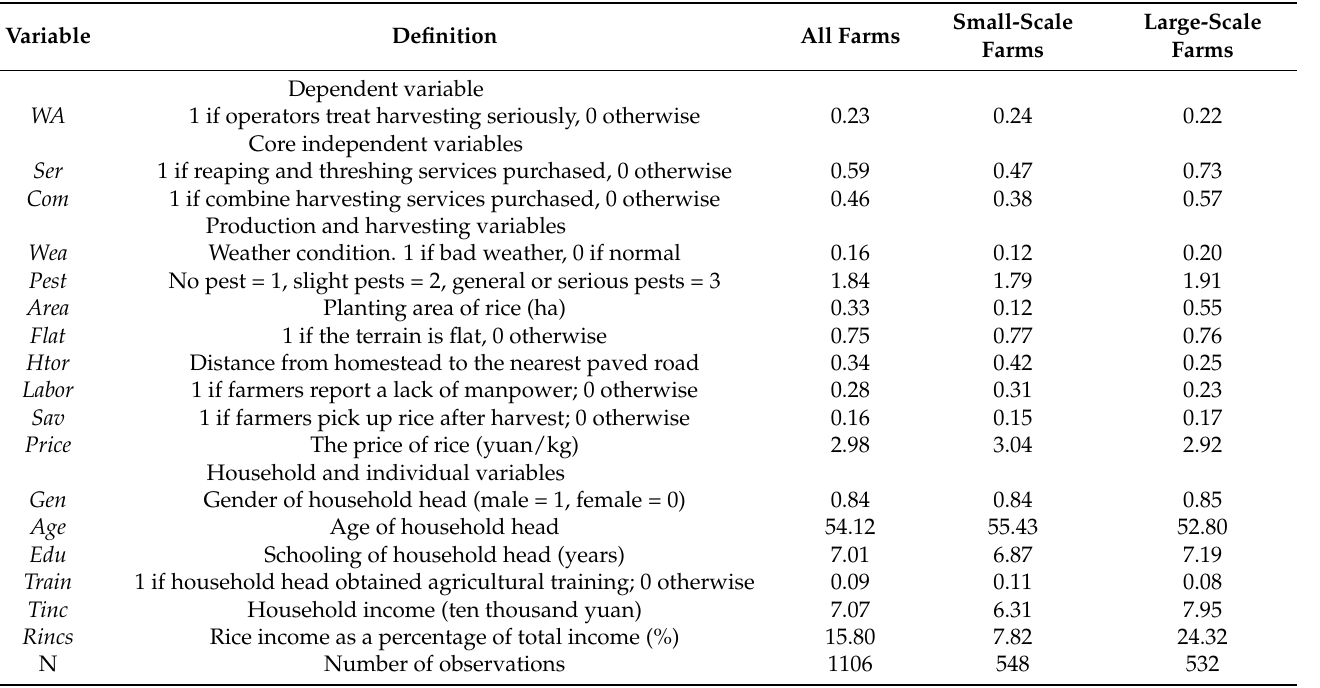
Table 2. Sample descriptive